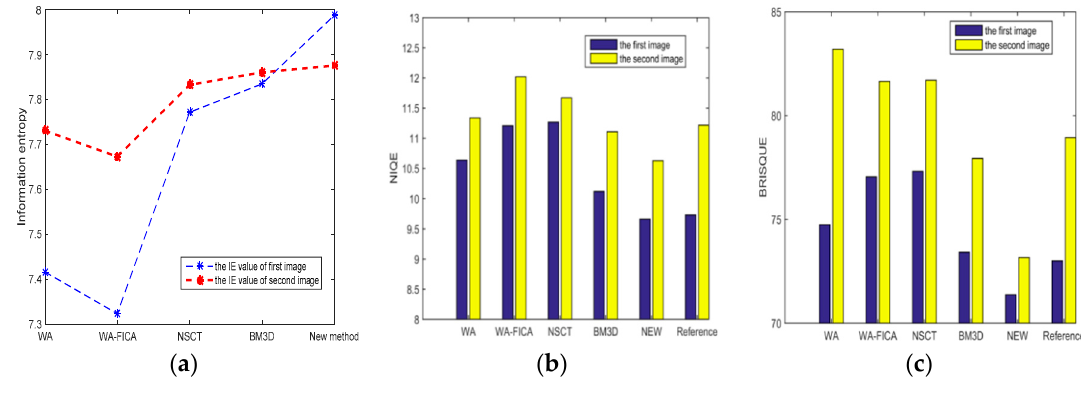
Figure 9. Comparison of different indexes: ( a ) IE; ( b ) NIQE; ( c ) BRISQUE.